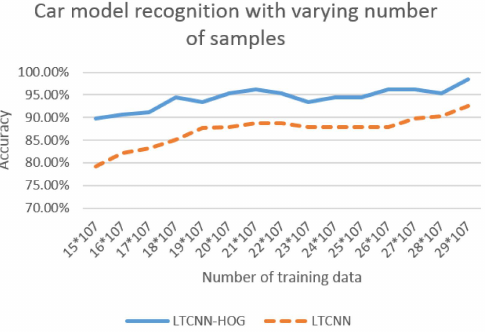
Figure 11. Accuracy of the vehicle-model recognition with different number of sample sizes for each experiment. The size of cell and HOG features are set to 10 ˆ 14 ˆ 36,